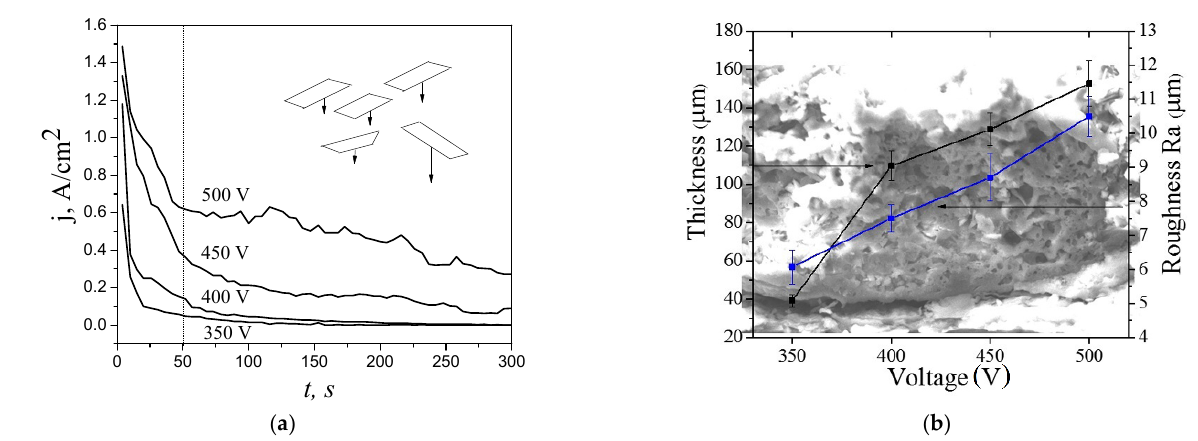
Figure 2. The plots of the current density versus the MAO process duration for the W-coatings’ deposition ( a ), the plots of the coatings’ thickness (black line) and Ra roughness (blue line) versus the applied voltage ( b ).